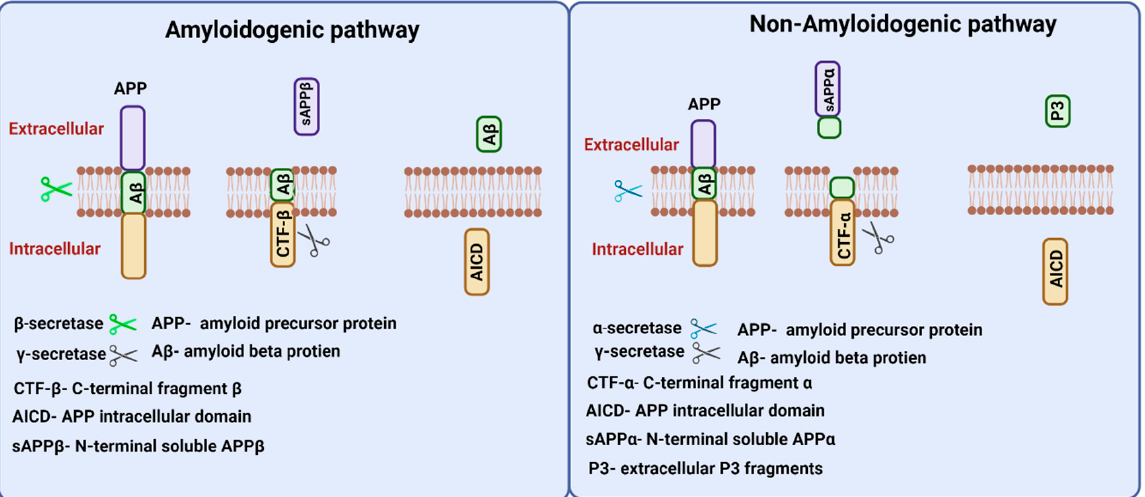
Figure 3. Amyloid precursor protein (APP) processing. Two proteolytic pathways, amyloidogenic and non-amyloidogenic processing, exist for APP processing. The amyloidogenic pathway involves β and γ secretases and releases N-terminal soluble APP β fragments, and A β peptides in the extracellular region. The non-amyloidogenic involves α and γ secretases and releases N-terminal APP α fragments, and P3 peptides in the extracellular region. Both proteolytic pathways release APP intracellular domain (AICD) fragments intracellularly.